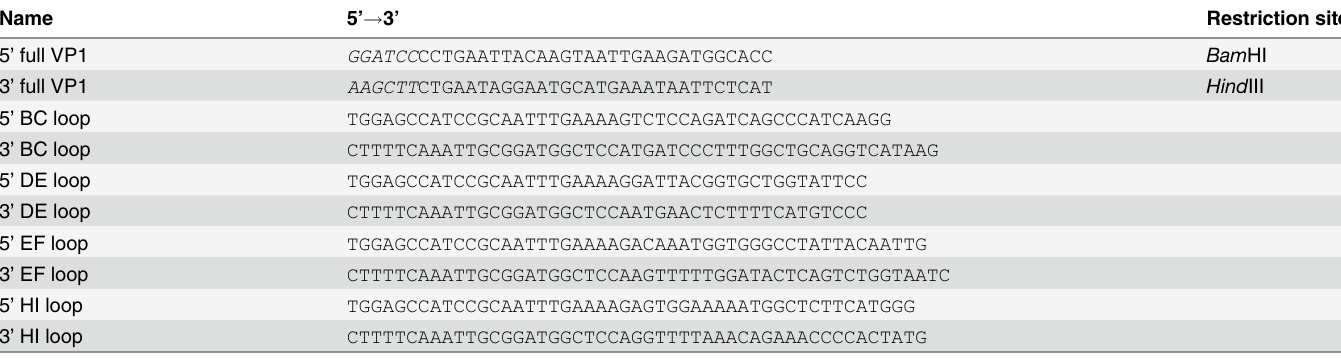
Table 1. Sequence of primers used for generation of MCPyV VP1 mutants